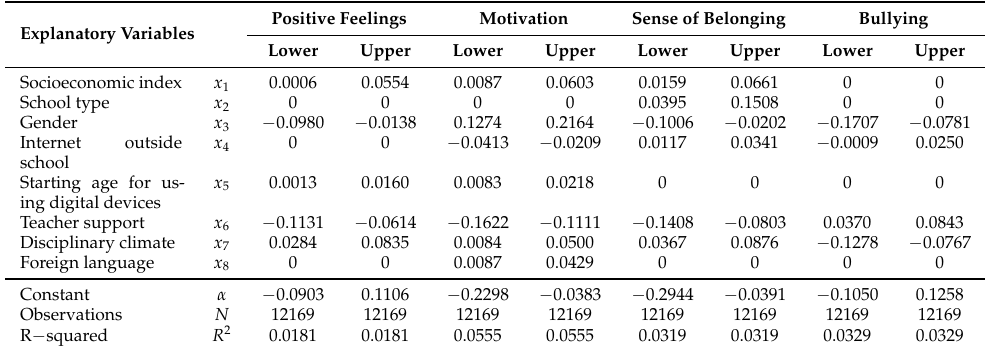
Table 3. Lower and upper bounds of the 95% confidence intervals for the regression coefficients for the Spanish sample.